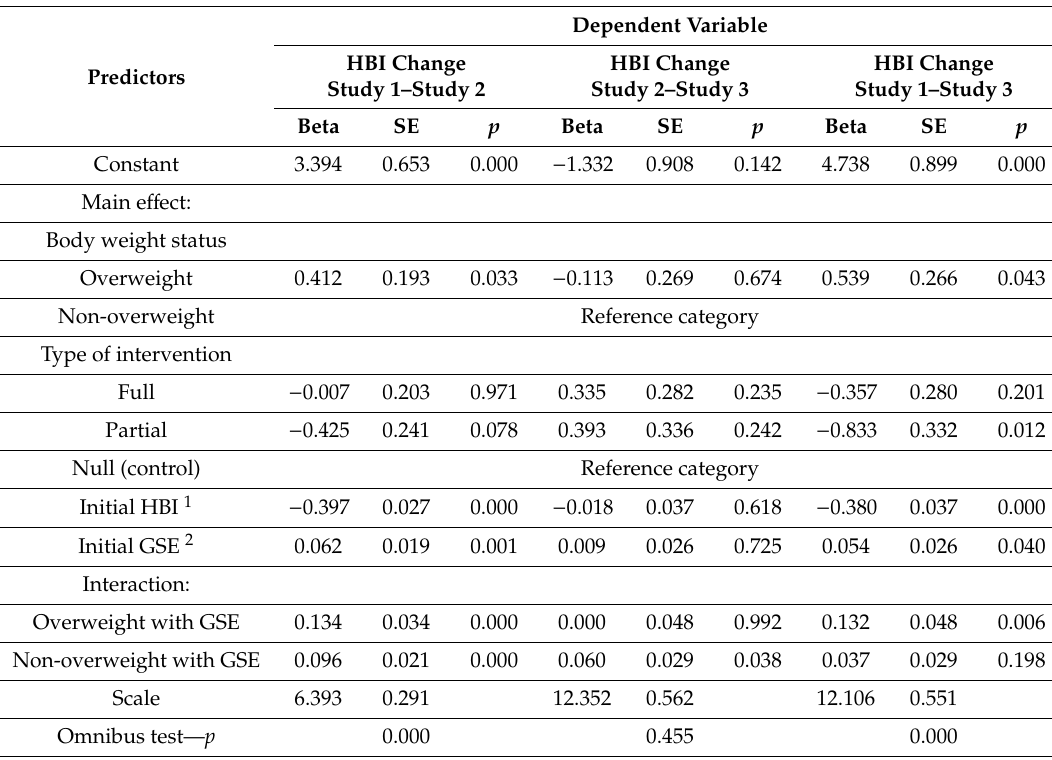
Table 5. Determinants of change in the HBI around the period of Healthy Me intervention identified by generalized linear